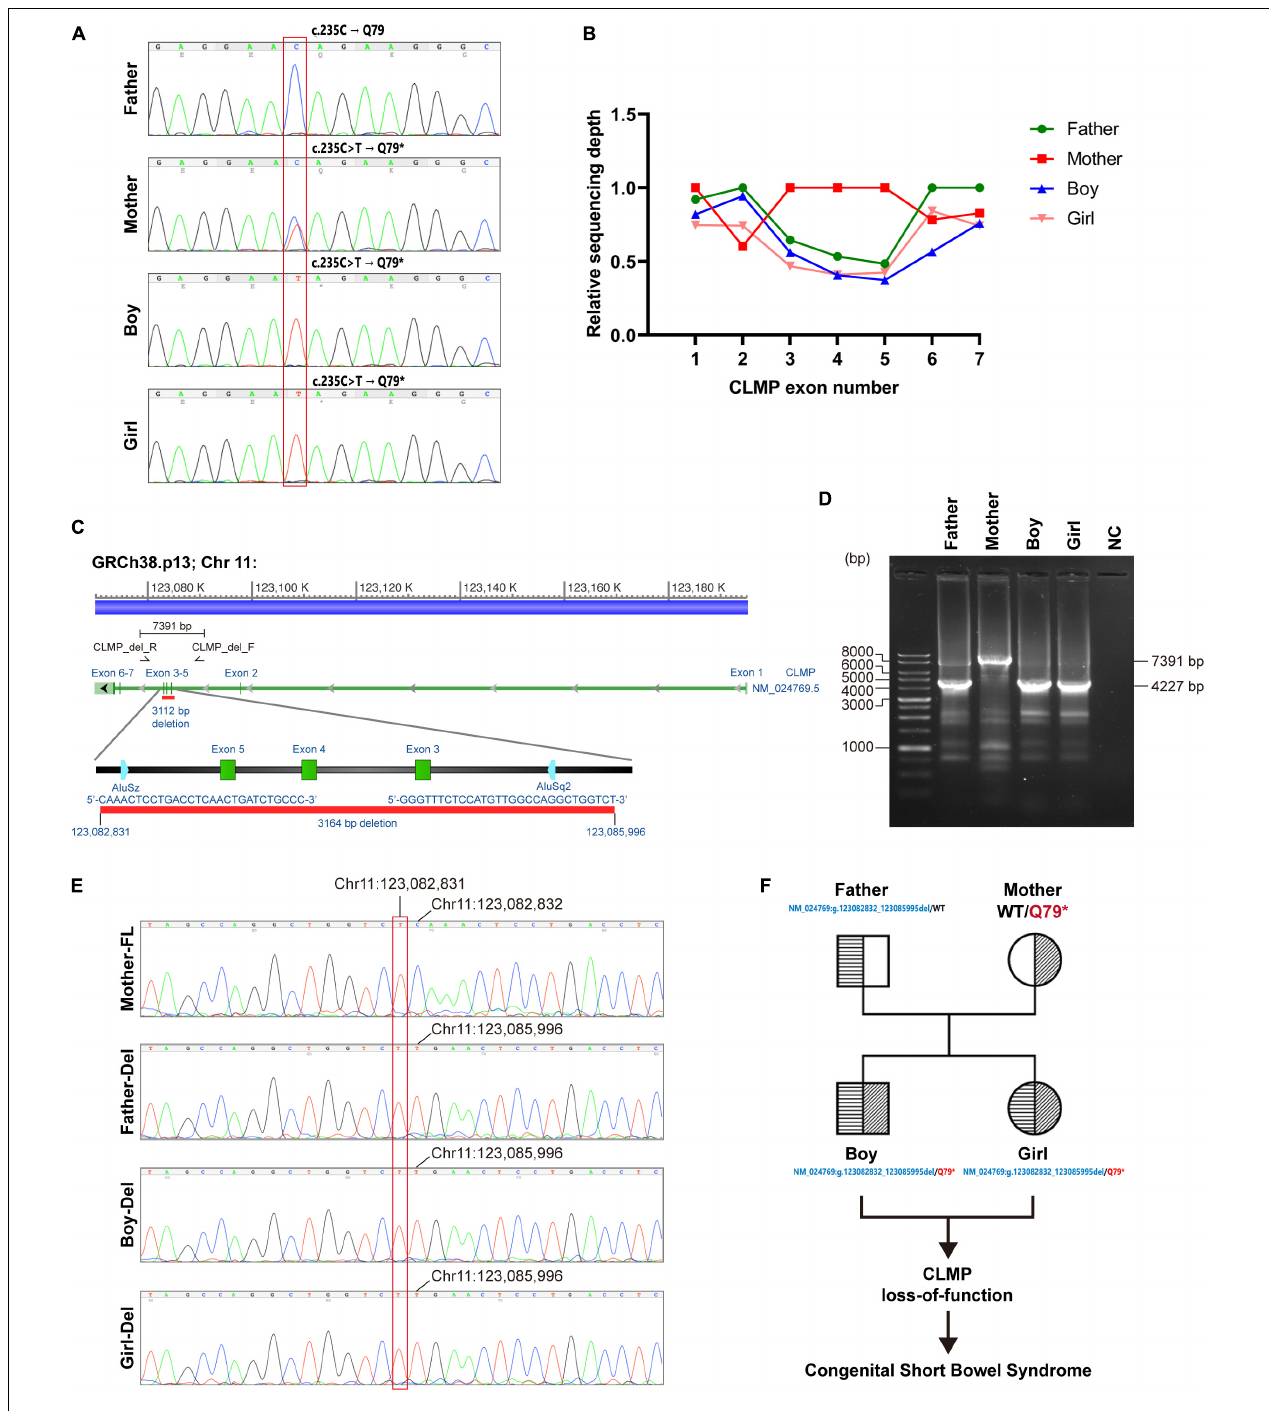
FIGURE 3 | Identification of potential causative genetic mutation within the CLMP gene in our cases with CSBS. (A) Sanger’s sequencing confirmed the c.235C > T (p.Q79*) point mutation in exon 3 of CLMP open reading frame (ORF) in both siblings (lower two panels) ; the father is wild type, and the mother is heterozygous. (B) The relative sequencing depth plot shows about one-half depths encompassing exon 3 to exon 5 of the father’s and two children’s reads than those of the mother’s reads. The average raw reads from individual bases in the same exon was normalized with the mean read of exon 1 from the mother to acquire the relative ratio. (C) The long deletion across exon 3–5 of the CLMP ORF was mapped by the girl’s whole-genome sequencing (WGS) (case-2). The primer set encompassing exon 3–5 for PCR is shown in the lower zoomed-in panel. (D) Gel electrophoresis of PCR products demonstrates large deletion (3164 bp) in the father and both siblings, compatible with the mapping by WGS. (E) Sanger’s sequencing confirmed the exon 3–5 deletion (chr11: 123,082,832_123,085,995del) in the father and two siblings. FL, full length; del, deletion. (F) The pedigree shows the inherence of CLMP genetic mutations in the family.